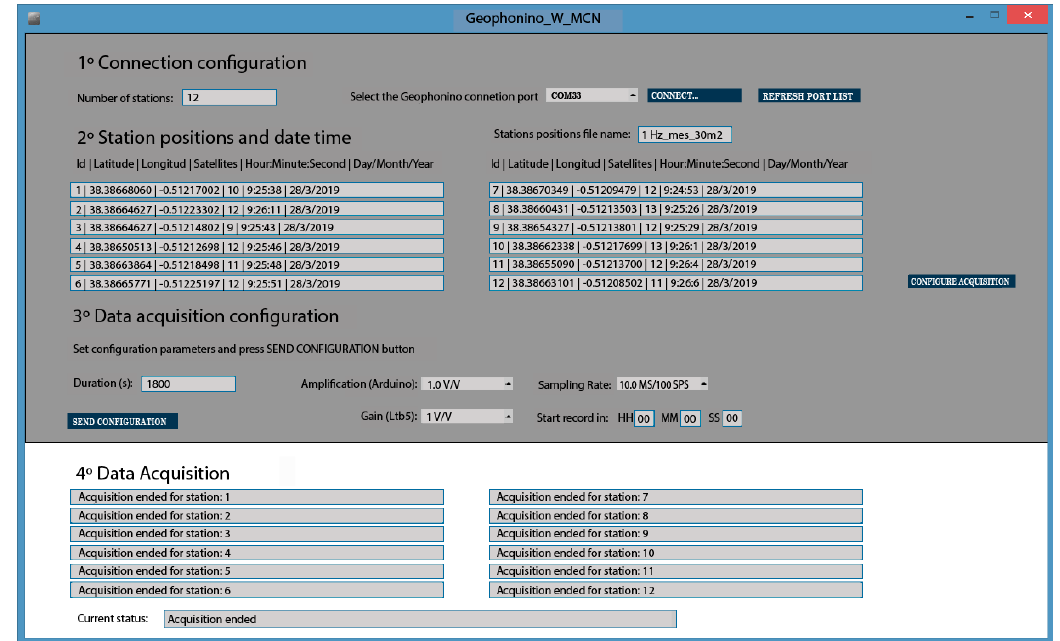
Figure 12. Graphical User Interface (GUI) of Geophonino-W. Screenshot after finishing a Figure12. data acquisition.